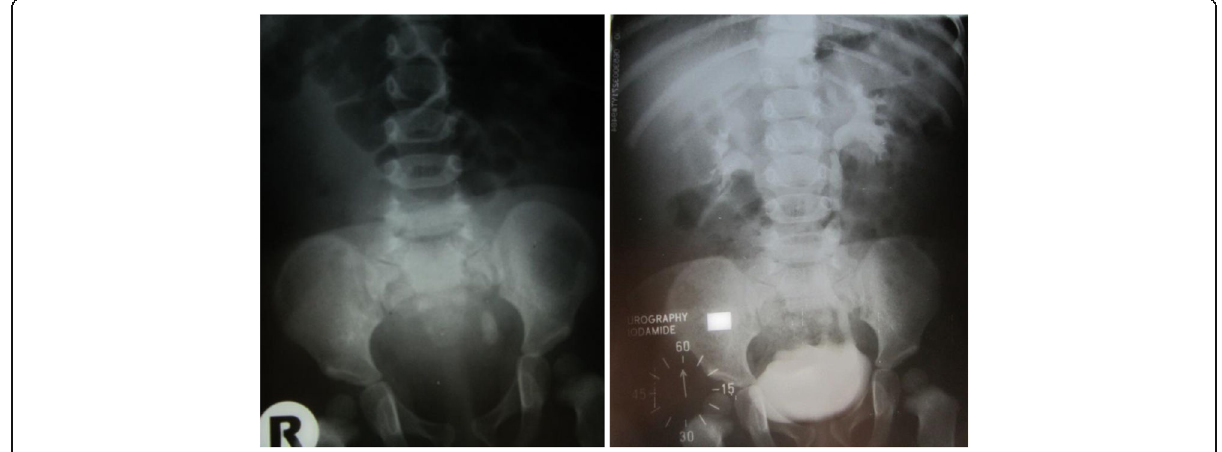
Fig. 1 X-ray findings of urolithiasis in patient with